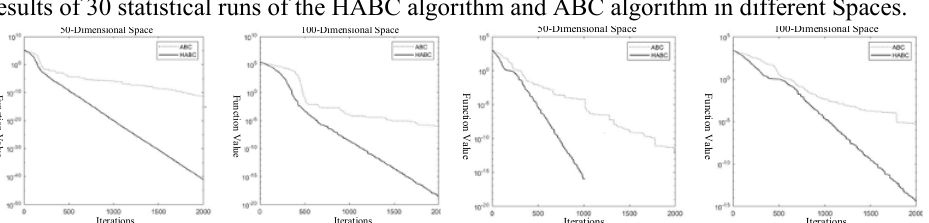
Fig. 1. The convergence curves of Sphere in 50- dimensional space and 100-dimensional space.